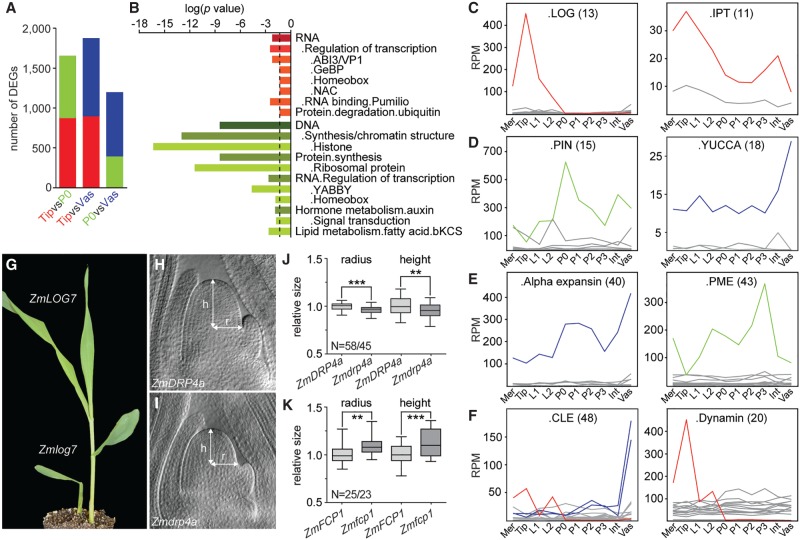
Differential expression of individual gene family members determines cell identity. (A) Pairwise differential gene expression analyses between Tip, P0, and vasculature show ∼10% of all expressed genes are differentially expressed (q < 0.01). Colors represent preferential expression within respective domains. (B) Enrichment analyses identified few functional categories overrepresented among Tip versus P0 DEGs. Dashed line, significance threshold (P = 0.05). (C–F) Individual genes within gene families show abundant and differential expression across the apex. Examples are shown for gene families functioning in cytokinin (C), auxin (D), cell wall (E), or other signaling processes (F). Number of family members is shown in parentheses. Only genes expressed ≥ 2 RPM are illustrated. Mer, meristem; Int, internode; Vas, vasculature. (G) Zmlog7 mutants display meristem termination phenotypes. (H,I) Cleared shoot apices of wild type (H) and the small meristem mutant Zmdrp4a (I). (J,K) Box-and-whisker plots of SAM size measurements of Zmdrp4a (J) or Zmfcp1 (K) and their respective wild-type siblings. (N) Number of wild-type/mutant apices measured. (**) P < 0.01, (***) P < 0.001, according to Student's t-test.